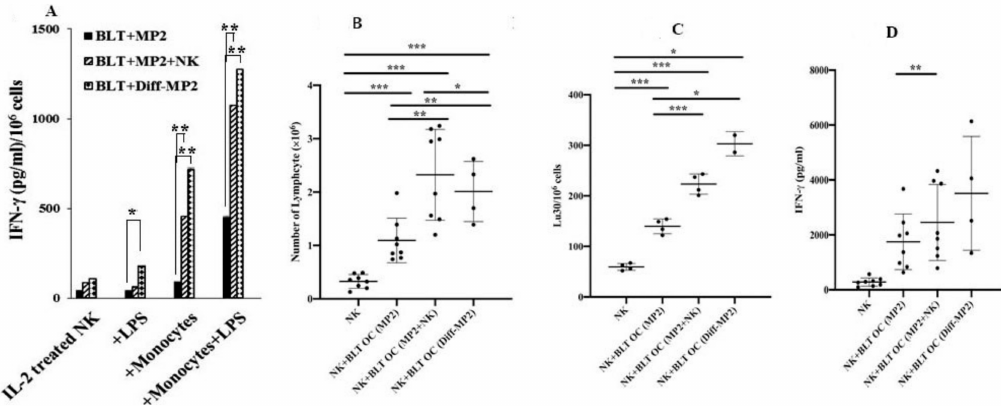
Figure 7. Monocytes or osteoclasts from tumor-bearing mice injected with NK cells or implanted with NK-di ff erentiated MP2 tumors induced increased IFN- γ secretion by the NK cells when compared to those of tumor-alone implanted mice. Hu-BLT mice were implanted with tumors and injected with NK cells, as described in Figure 4A before spleen and BM were harvested and single cell suspensions were prepared. CD56 + NK cells were positively selected from splenocytes, and monocytes were purified from the BM cells, and co-cultured at (NK:Monocytes; 2:1 ratio) and treated with IL-2 (1000 U /